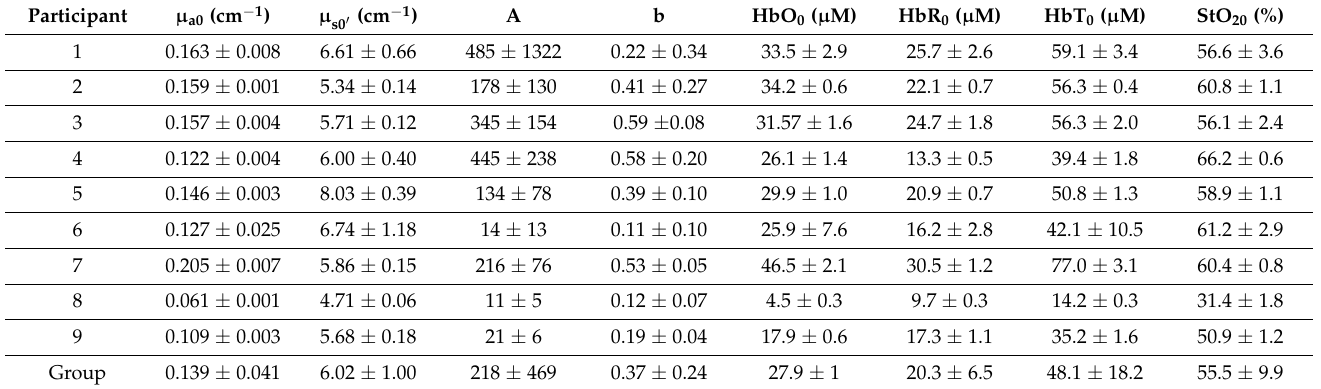
Table 1. Resting-state optical properties and hemoglobin concentrations. Mean ± standard deviation of resting-state absorption and reduced scattering coefficients ( µ a0 and µ s0 ’, respectively) at 852 nm, µ s0 ’ scaling factor (A) and scattering power (b), as well as oxy- and deoxy-hemoglobin concentrations (HbO 0 and HbR 0 , respectively), total hemoglobin concentration (HbT 0 ), and oxygen saturation (StO 20 ) for each participant across 11 repetitions. Group averaged results are shown in the bottom row.